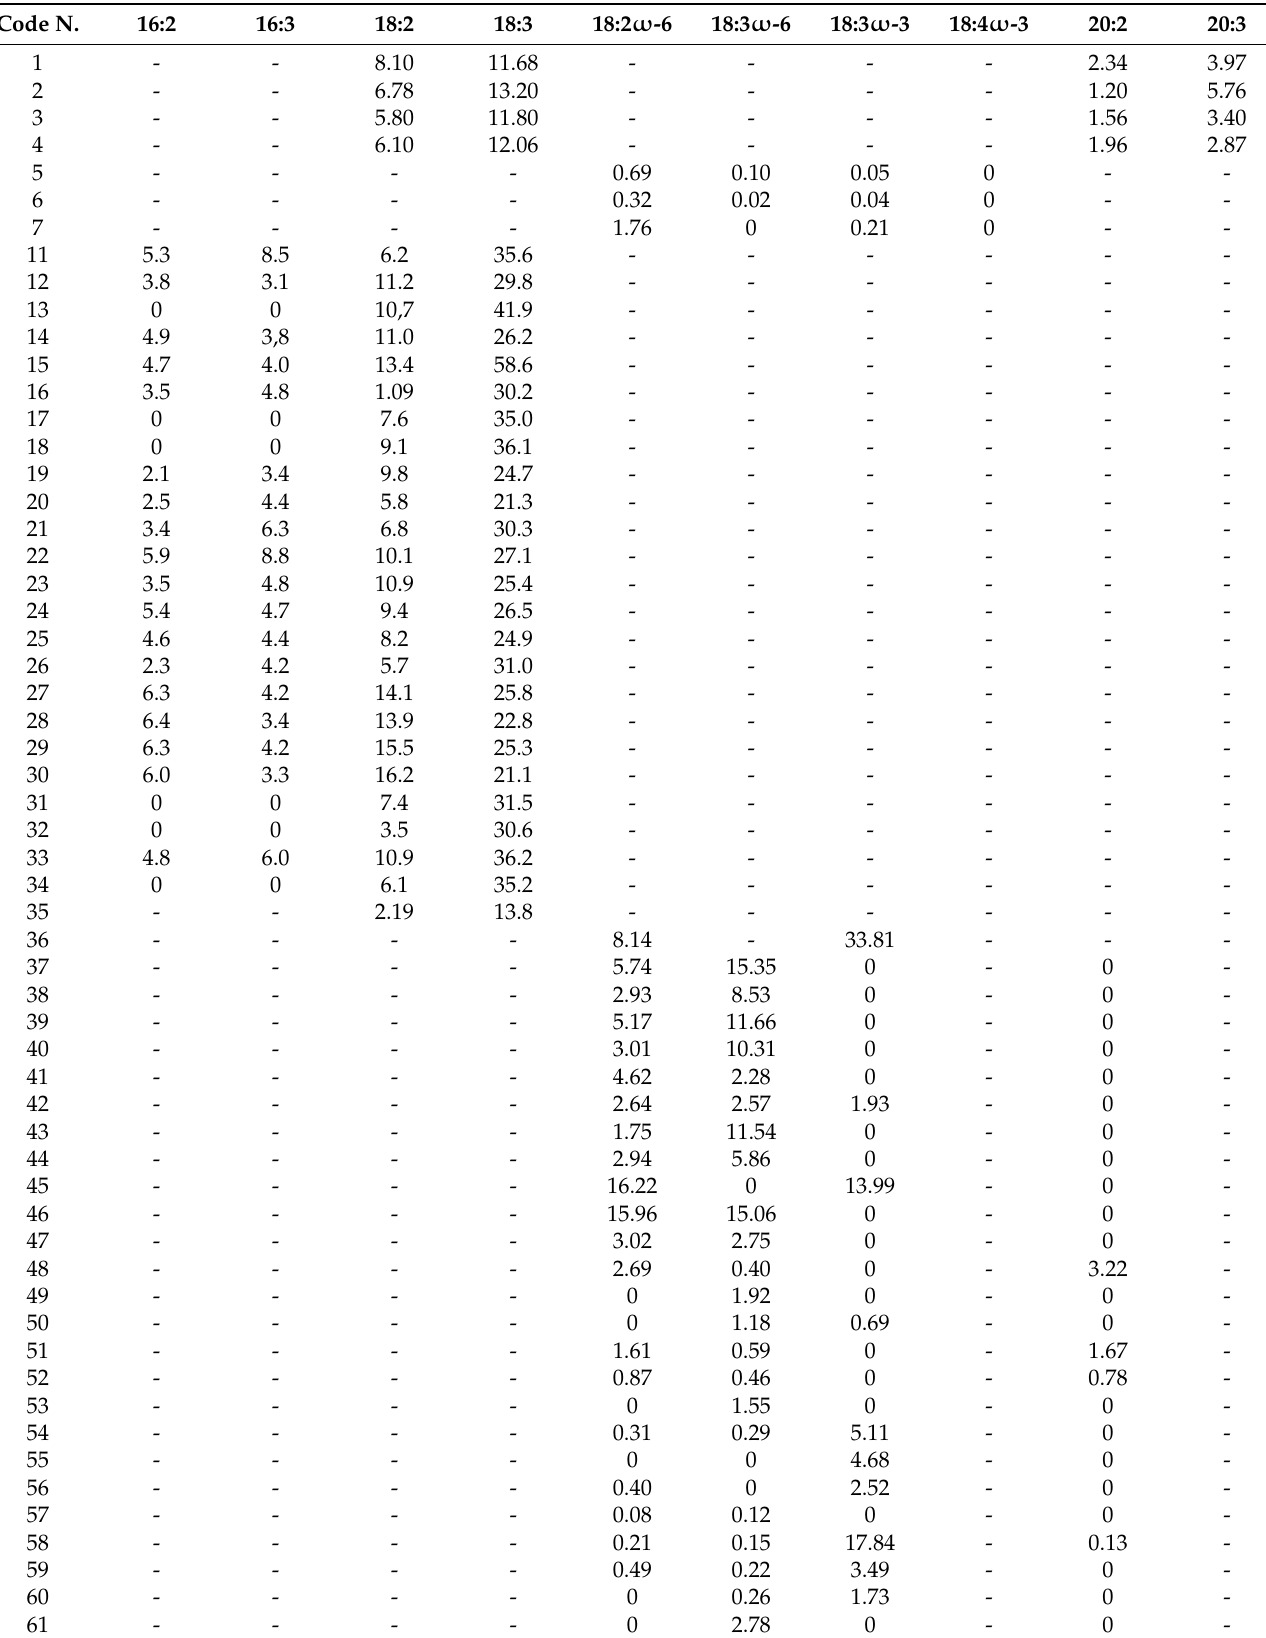
Table 4. Polyunsaturated fatty acid composition of cyanobacteria selected for this review 1,2 . Code